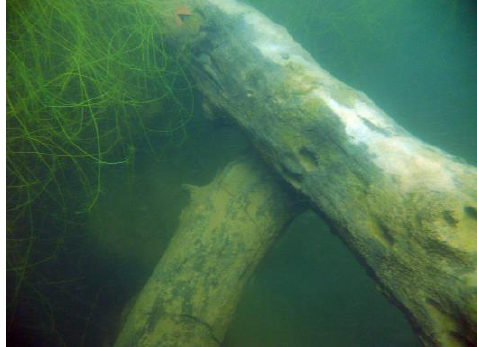
Figure 9. Gambulaga – Portomaggiore (FE), Tramonto Lake, big tree trunks.